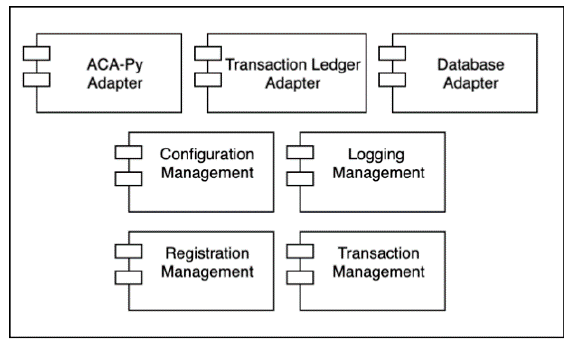
Figure 22. EVSEO software modules. EVSEO implementation.